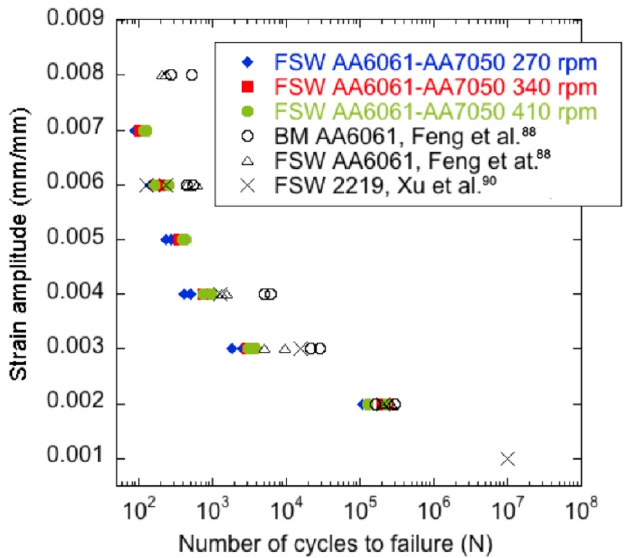
Figure 16. Fatigue life for the dissimilar AA6061-to-AA7050 and comparison to results from literature [21].